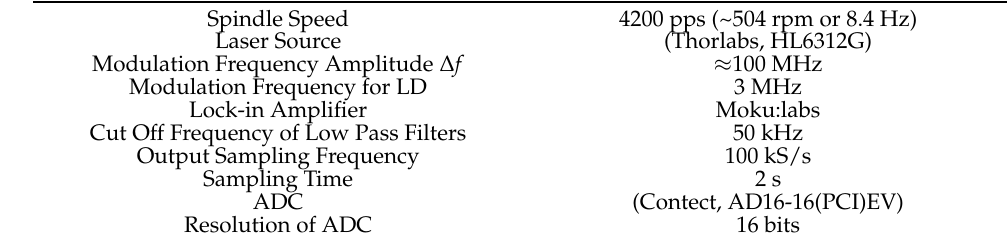
Table 1. Experimental